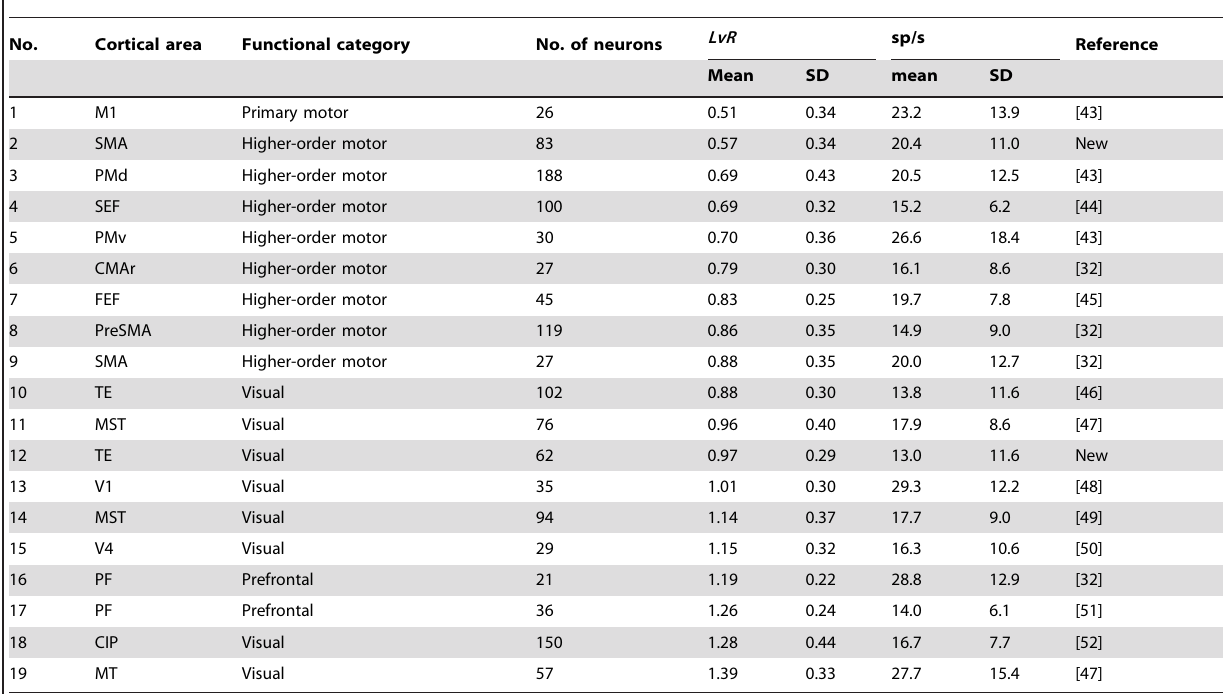
Table 1. List of the cortical areas, experimental attributes and references for neuronal spike data (in order of ascending mean LvR ).